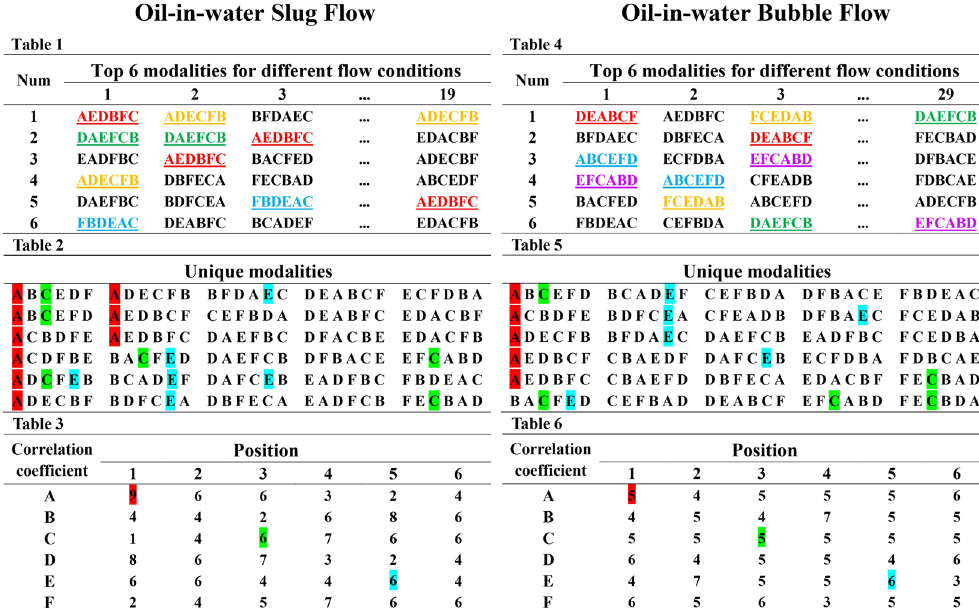
Figure 10. The analysis of the critical modalities in oil-water slug flow and bubble flow. Table 1 presents the top 6 critical modalities in 19 oil-water slug flow conditions; Table 2 shows the unique modalities from Table 1 (i.e., all the modalities that appear in Table1 are listed only once in Table 2); and we break down the unique modalities in Table 2 and map the results into Table 3, where the element A1 in the A row and the 1st column shows the statistic of the correlation coefficient A in the 1st position in unique modalities. And similarly, Table 4, Table 5, and Table 6 are for 29 oil-water bubble flow